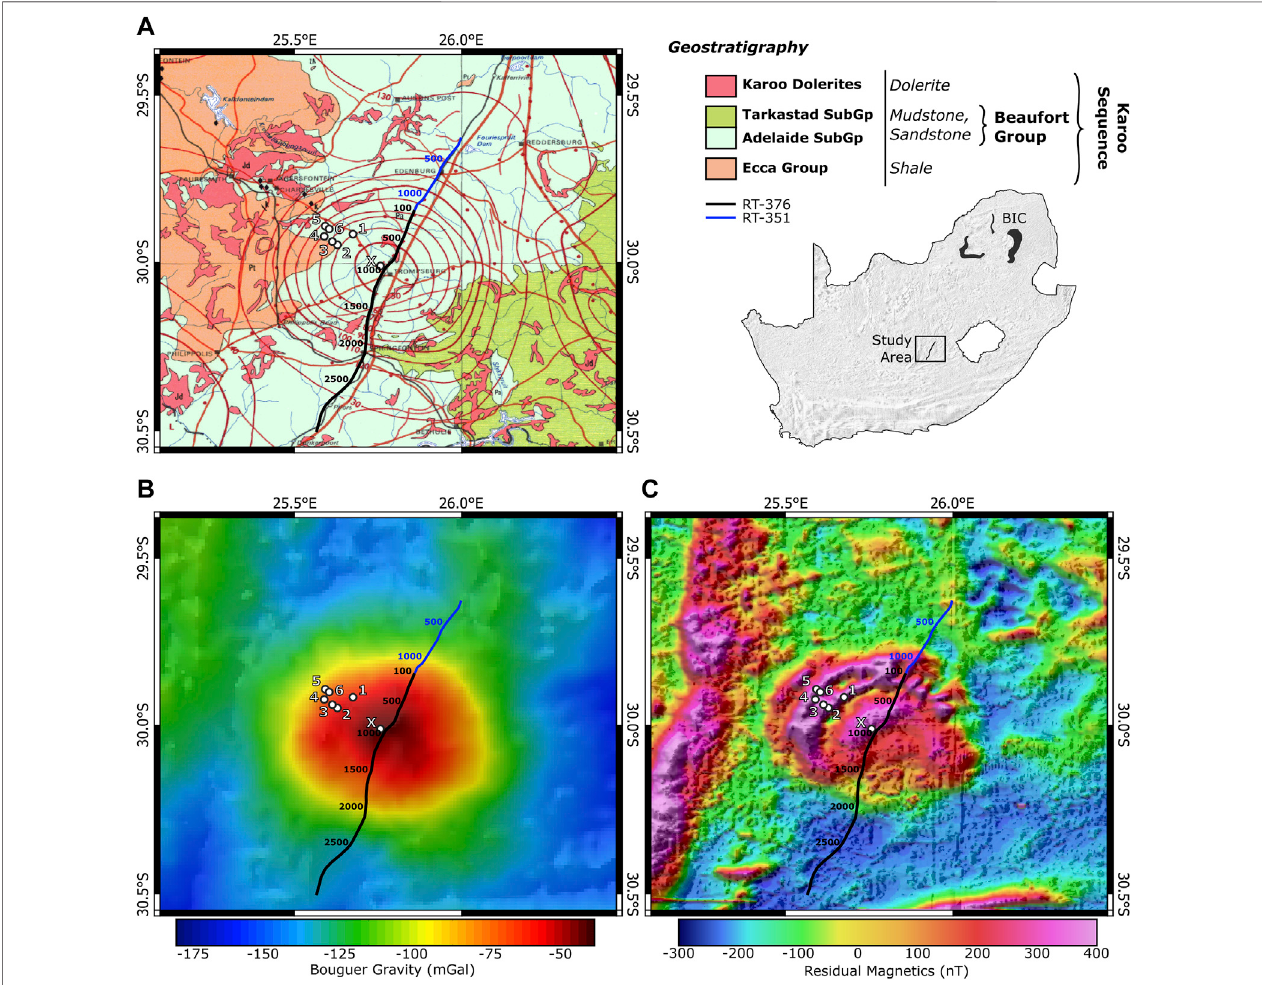
FIGURE 1 | Geological (A) and potential fi eld maps, gravity in (B) and magnetic in (C) , of the Trompsburg anomaly with seismic pro fi les P1 (RT-376) and P2 (RT- 351) overlaid in black and blue, respectively. Pro fi le CMP numbers are labelled every 500th CMP. Boreholes are labelled 1 through 6 in the NW and X in the centre, corresponding to boreholes TG1 through TG6 and TGX, respectively. BIC, Bushveld Igneous Complex.